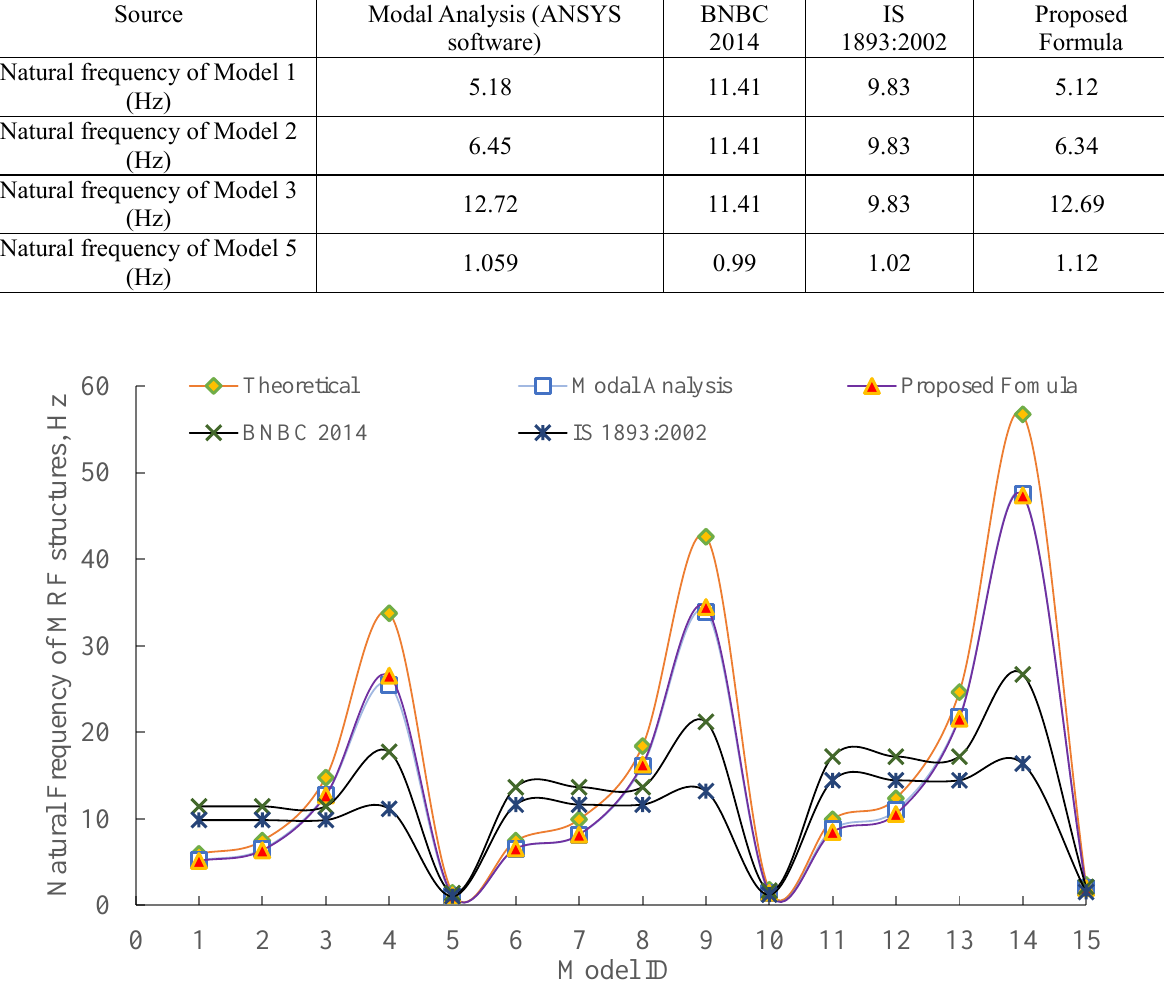
Fig. 5. Natural Frequency of MRF Structures using different